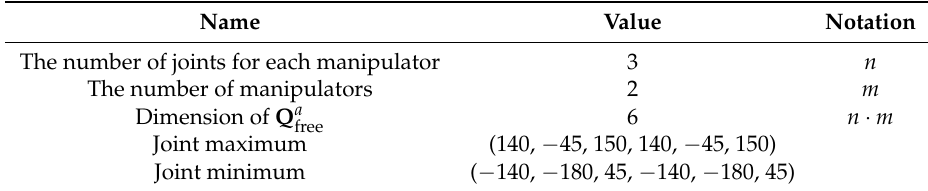
Table 1. Parameters of the 3-DOF manipulator.